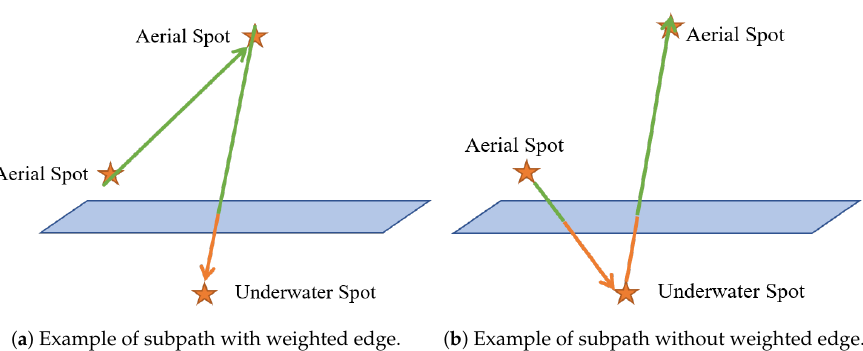
Figure 8. This figure illustrates a comparison between weighted edge and non-weighted edge path generation with the same spots set. The underwater part of the path is orange, and the aerial part is green. Without weighted edges, the HAUV will choose a shorter path that is more energy